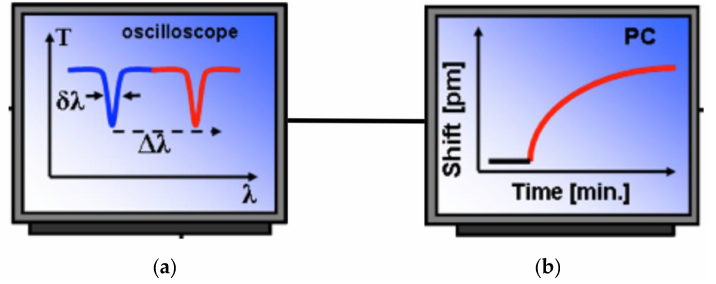
Figure 9. ( a ) Schematic WGMR transmission line shape before (blue) and after (red) a resonant shift; ( b ) Resonant shift versus time